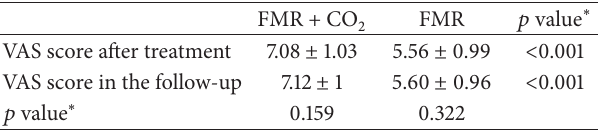
Table 3: Mean of patient satisfaction VAS score after treatment and in the follow-up in both groups. FMR + CO 2 FMR